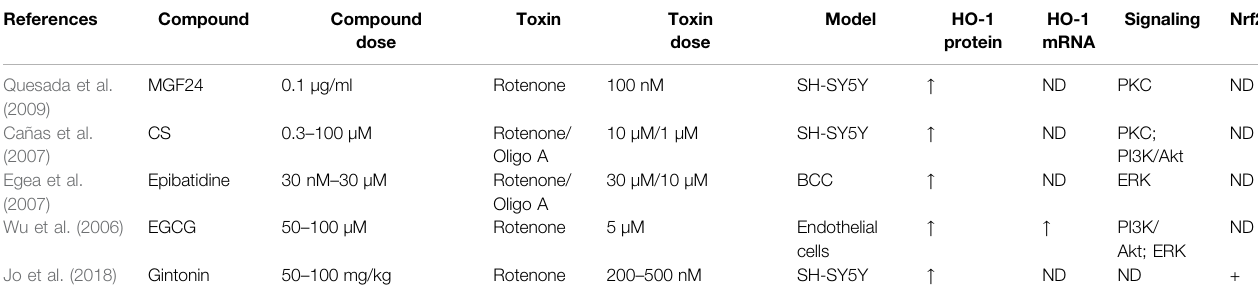
( Table 9 ), paraquat ( Table 10 ), and rotenone-induced ( Table 11 ) neurotoxicity in vitro or in vivo PD models.